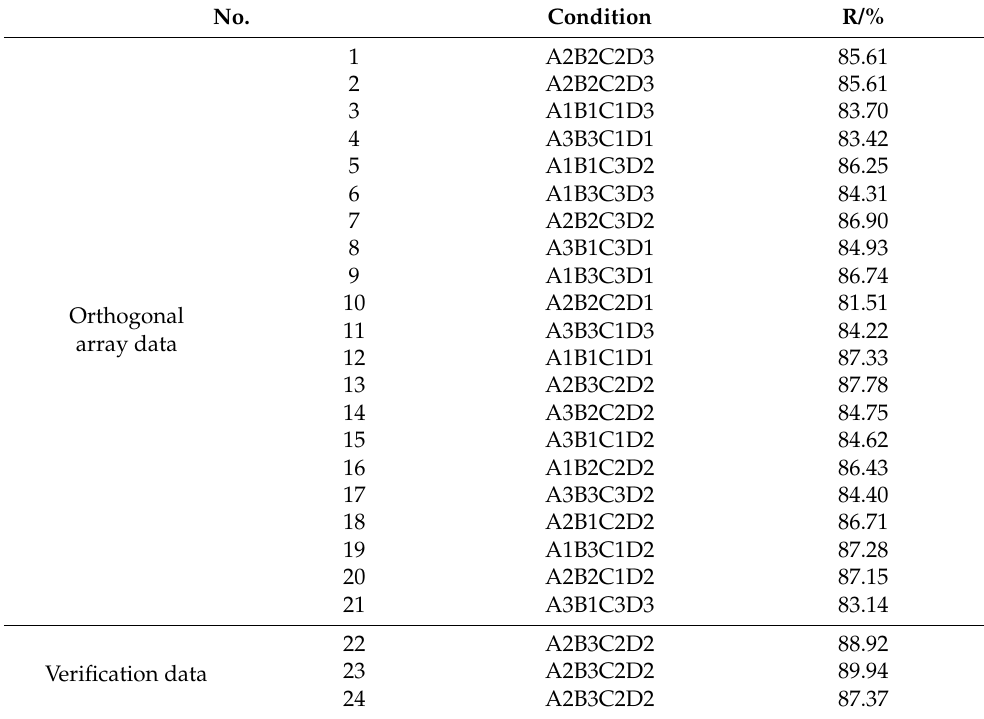
Table 2. The R of samples with different conditions.